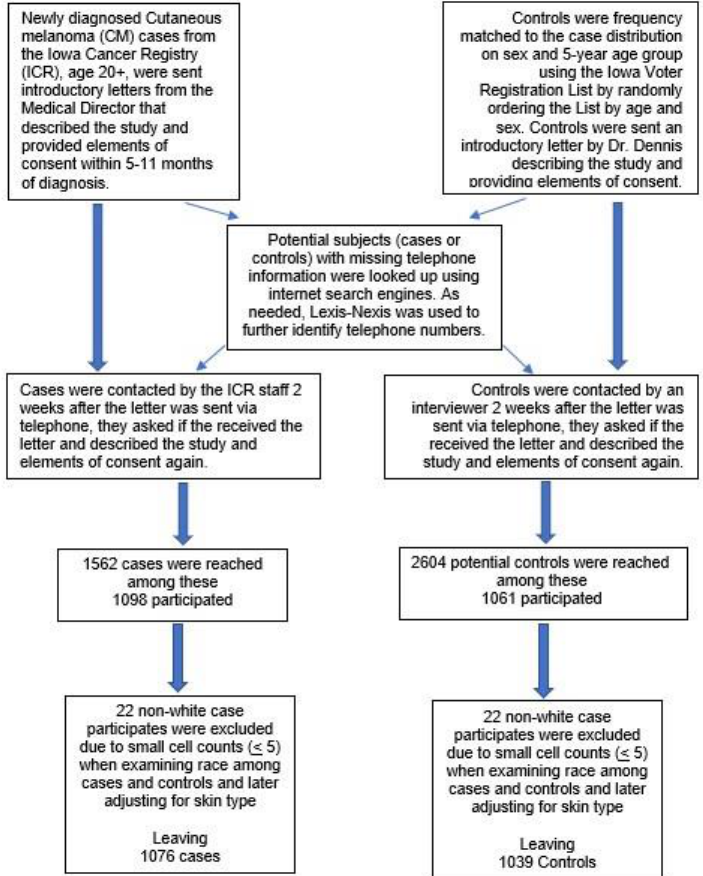
Figure 1. Recruitment of subjects.